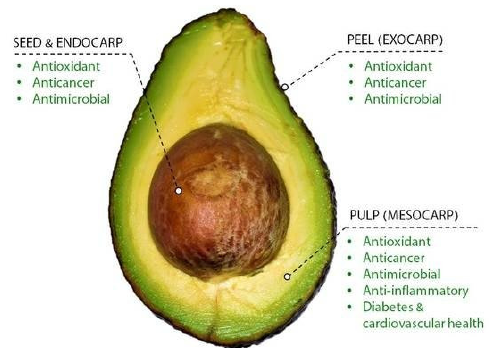
Figure 1. Avocado parts and properties. Reprinted with permission from Bhuyan et al. The Odyssey of Bioactive Compounds in Avocado (Persea americana) and Their Health Benefits. Antioxidants . Copyright (2019) MDPI